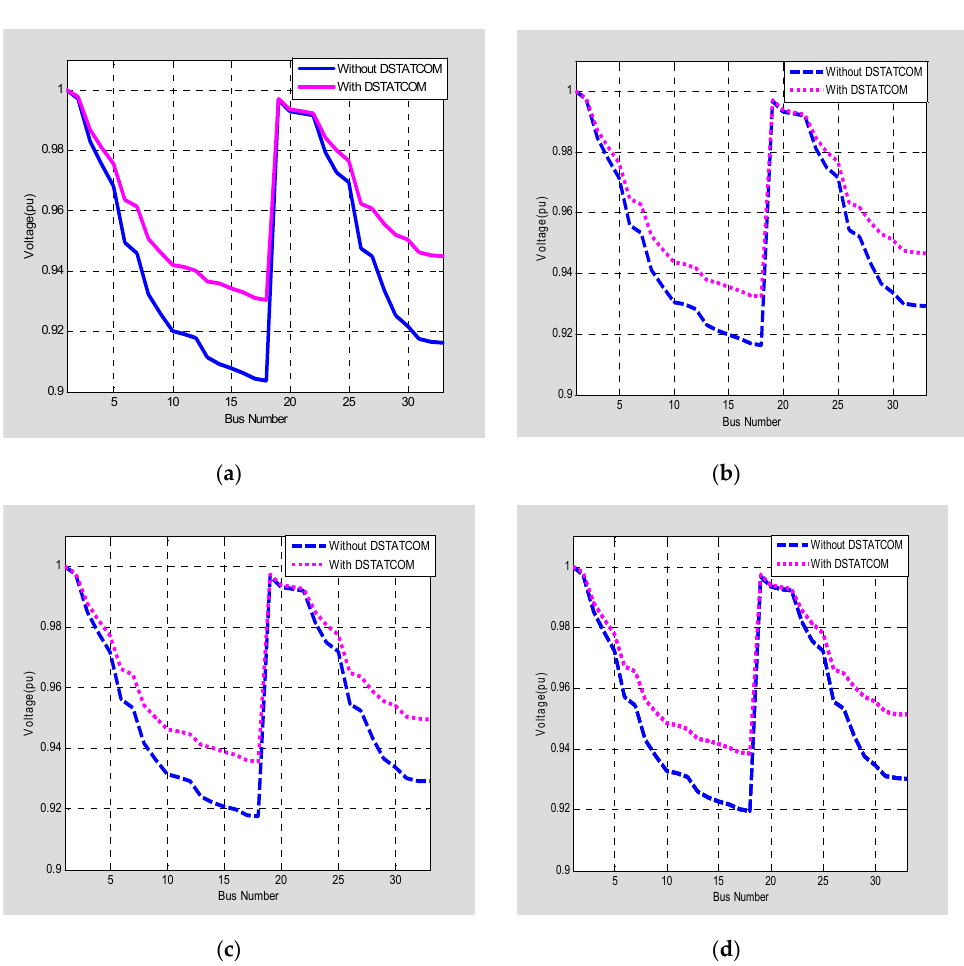
Figure 4. Voltage profile of standard 33-bus test system under different load models: ( a ) Constant Load, ( b ) Industrial Load, ( c ) Residential Load, and ( d ) Commercial Load.